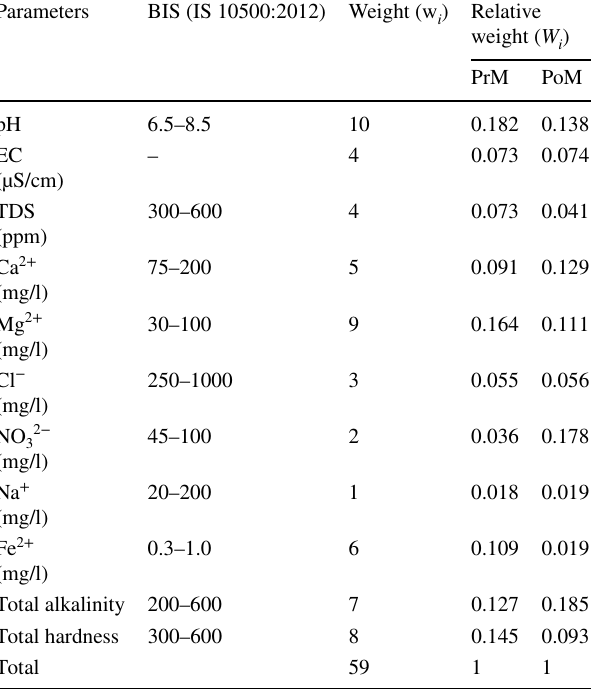
Table 7 Relative weight of chemical parameters for WQI index Parameters